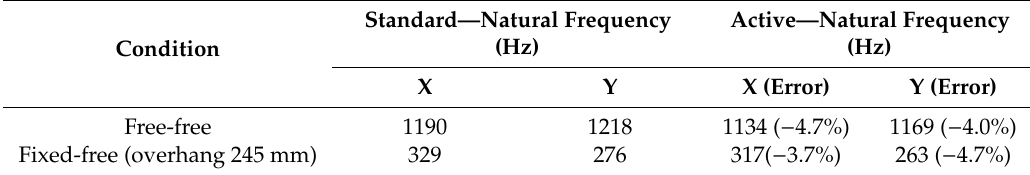
Table 7. Comparison between original boring bar and active boring